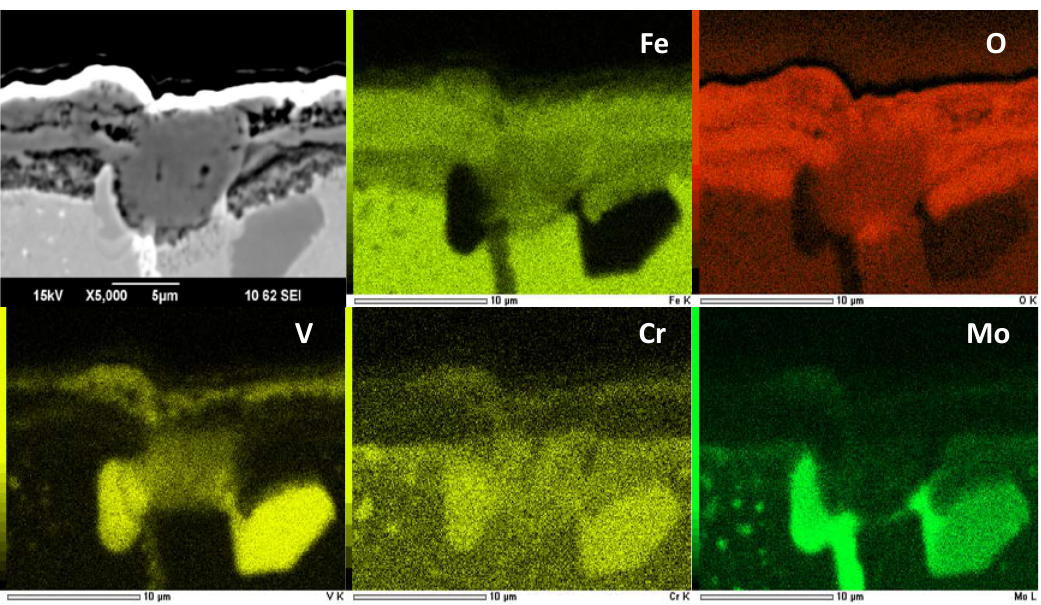
analysis of the HSS oxidized at 650 °C in ( a ) dry air and ( b ) humid air.